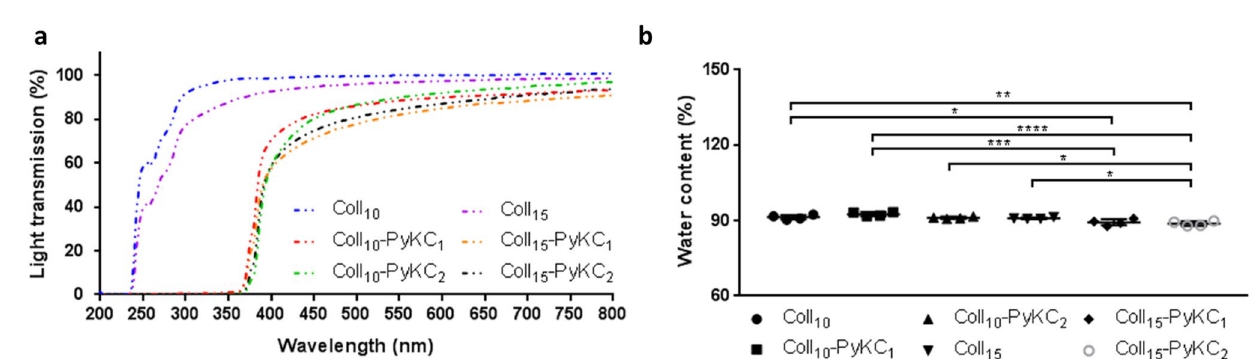
Figure 2. Characterization of crosslinker free Coll-PyKC hydrogels. ( a ) Light transmission measurement through PyKC collagen hydrogels (N = 3) in the wavelength range of 200–800 nm compared with EDC/NHS crosslinked collagen hydrogels. ( d ) The water content of PyKC hydrogels were compared with two control collagen hydrogels (N = 4), Coll 10 and Coll 15 . A value of p < 0.05 was considered statistically significant. *, **, *** and **** represent p < 0.05, p < 0.01, p < 0.001 and p < 0.0001,